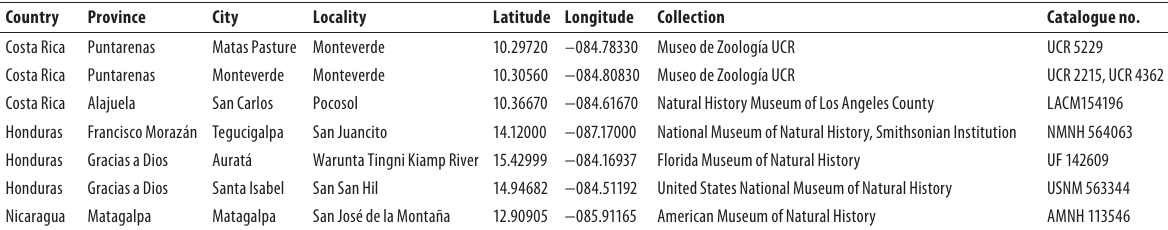
Table 1. Historical records of Amerotyphlops costaricensis mapped in Figure 1. Country Province City Locality Latitude Longitude